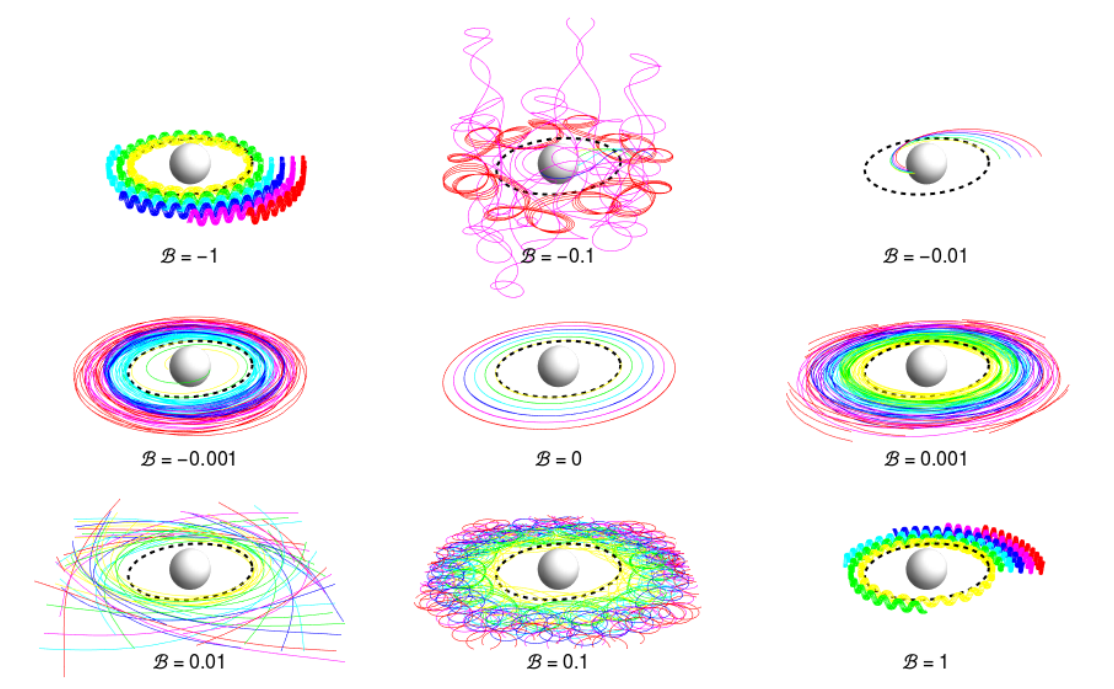
Figure 12. Thin Keplerian accretion disk around Schwarzschild BH in uniform magnetic field, created by neutral test particles following circular geodesics, and its evolution when the influence of the magnetic field is switched on. The accretion disk particles are following initially circular orbits with slight inclination from equatorial plane ( θ 0 = 1.5), while the magnetic field lines are everywhere aligned with the z -axis (vertical direction). The figures are labeled by the values of magnetic parameter , as in the following corresponding figures generated for various values of spin a . The uncharged test B particles on innermost stable spherical orbit (depicted by the dashed circle) represent the inner edge of the Keplerian accretion